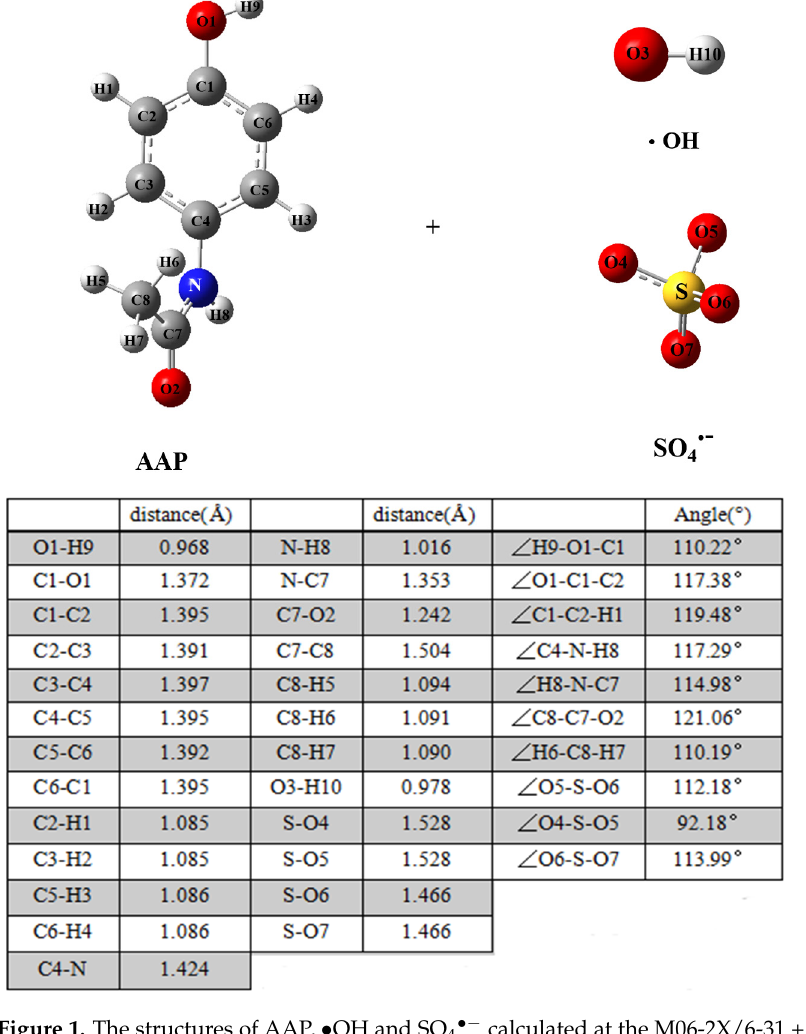
Figure 1. The structures of AAP, •OH and SO 4• − calculated at the M06-2X/6-31 + G(d,p) level. The bond distance (Å) and angles (°) are listed. Here, .